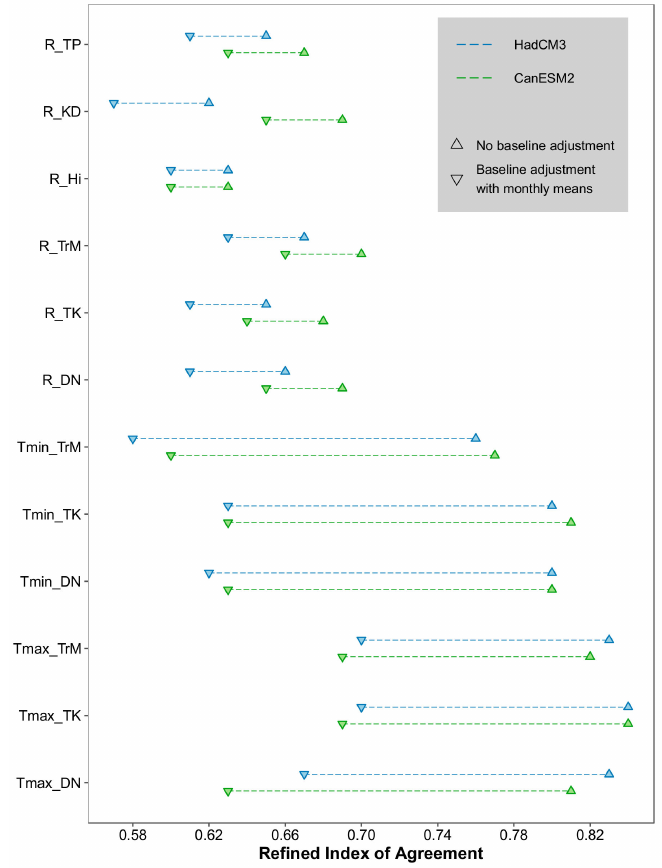
Figure 5. The values of refined index of agreement with / without baseline adjustments during validation. Tmax, Tmin, and R stand for maximum and minimum temperature and